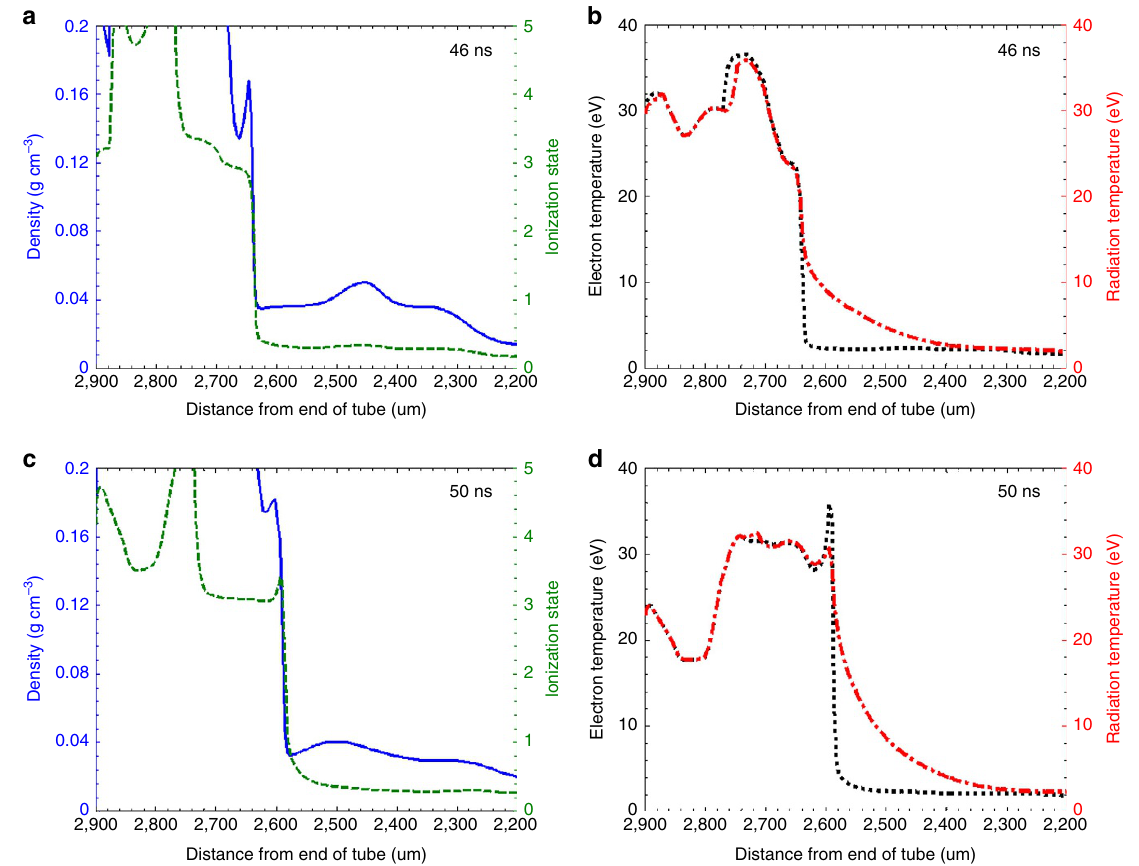
Figure 4 | Prediction from numerical simulations. Lineouts, from the central axis of a 2D simulation, of various plasma properties are shown at two different times. Density and ionization state ( a , c ) are shown as solid blue and dashed green lines, respectively; electron temperature and radiation temperature ( b , d ) are shown as dotted black and dot-dashed red lines, respectively. At the shock position we see an abrupt change in all four of these properties.